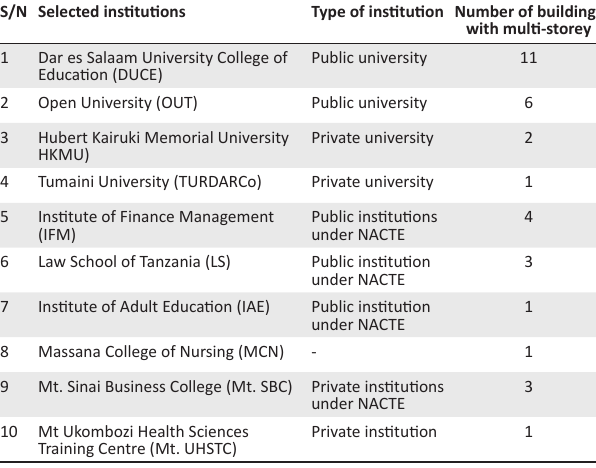
TABLE 2: Institution sampled for the study.